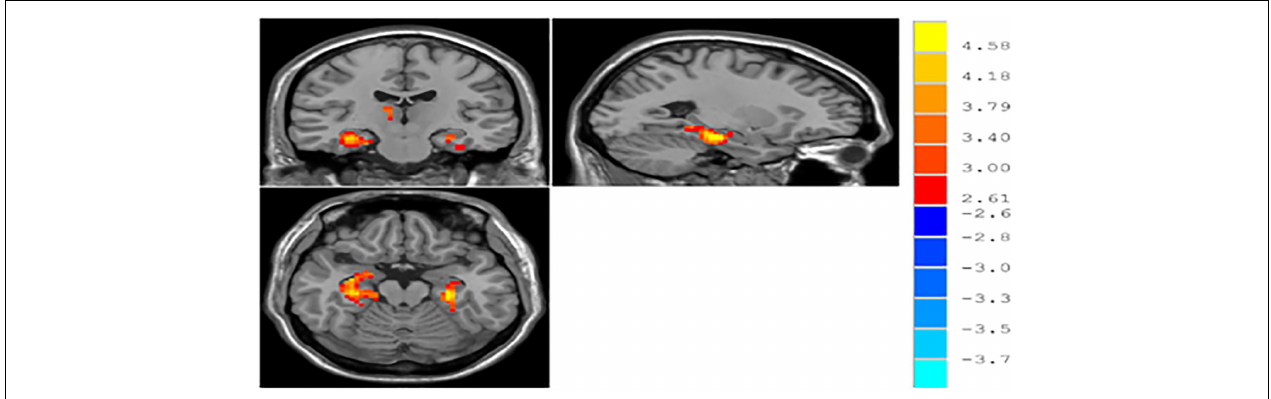
FIGURE 1 | | Brain regions with different ReHo between patients with major depressive disorder (MDD) and normal controls.